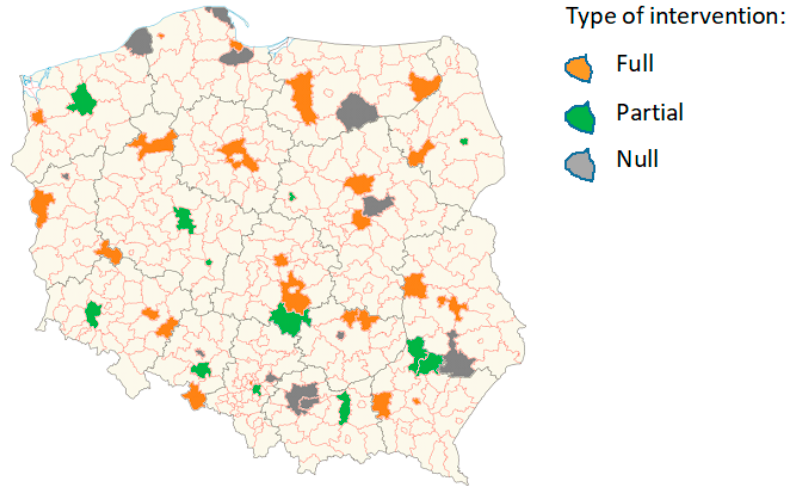
Figure 1. Location of schools participating in the Healthy Me program by the type of intervention.